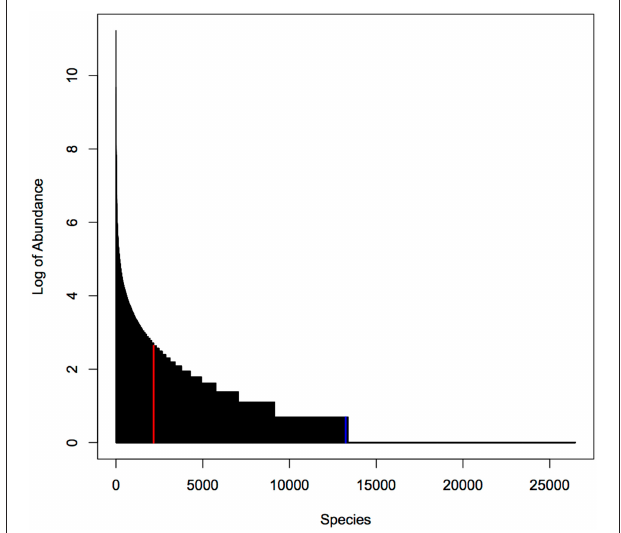
FIGURE 1 | Distribution of abundance (averaged over 88 samples). Red line indicates median abundance, blue line indicates average abundance. Note that y-axis is on a log scale.